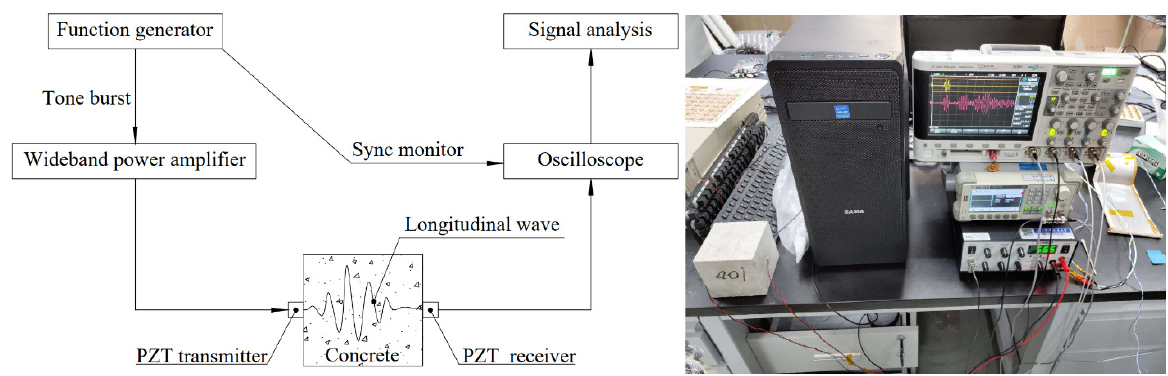
Figure 2. Detection device for the non-linearity parameter of ultrasonic longitudinal